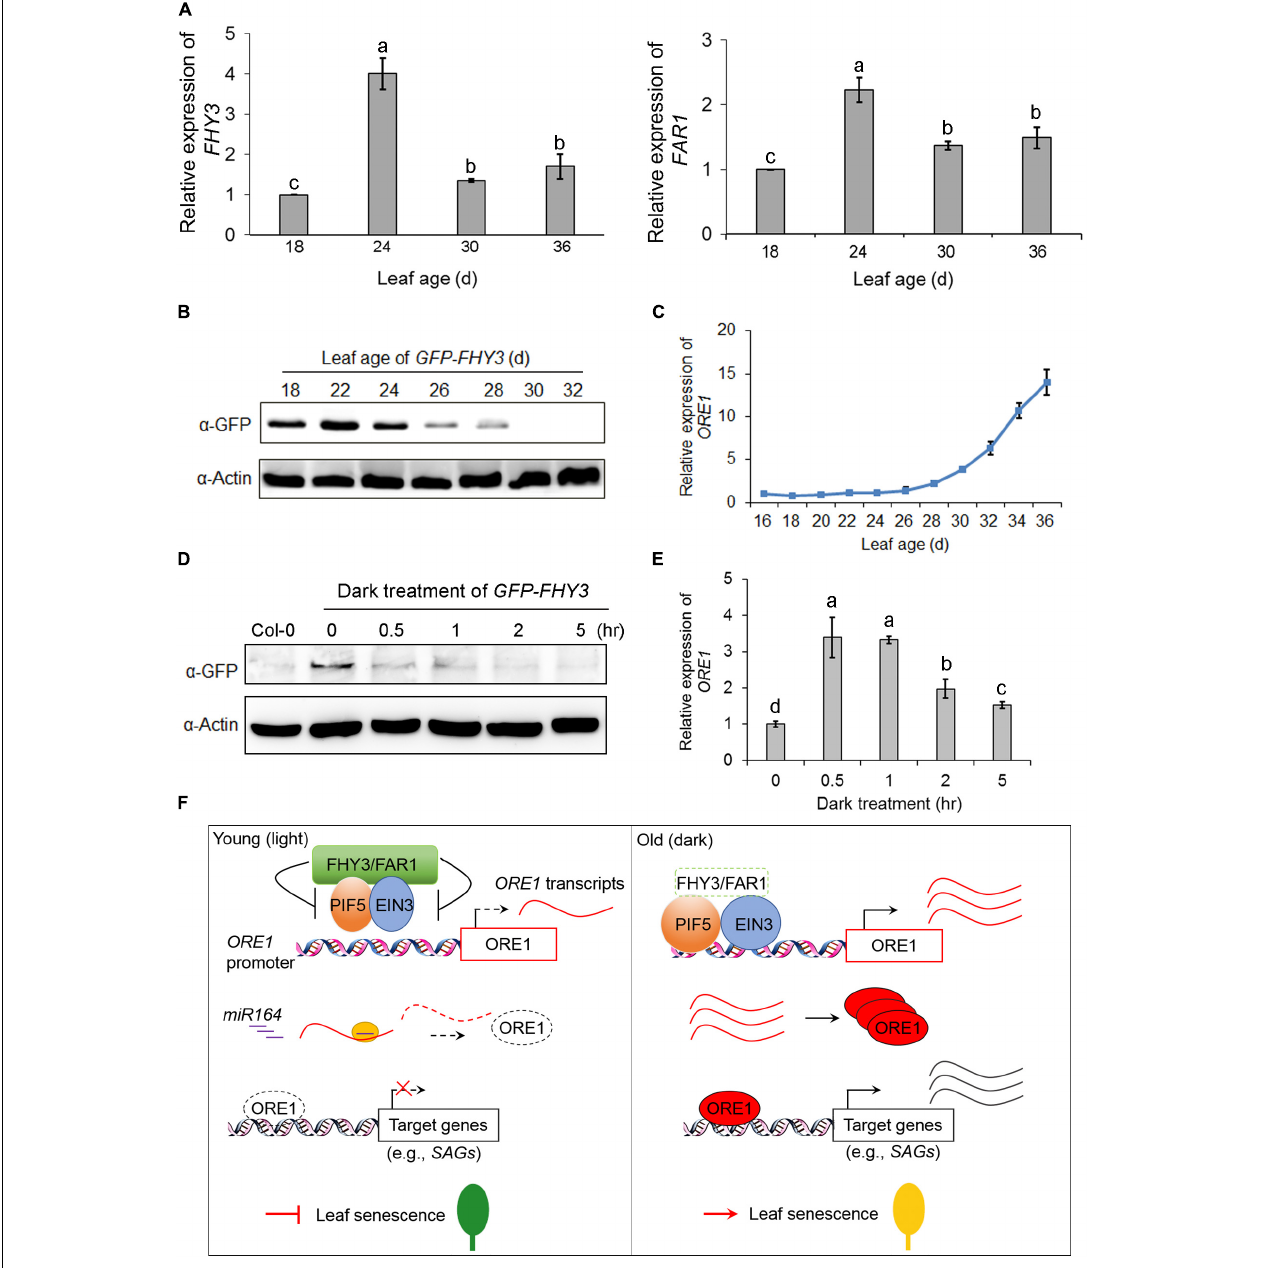
FIGURE 7 | qRT-PCR analysis of FHY3 and FAR1 transcripts and immunoblot analysis of FHY3 protein accumulation. (A) qRT-PCR analysis of FHY3 (left) and FAR1 (right) expression in the fourth leaves of Col-0 at the indicated leaf age. Error bars represent SD ( n = 3). Letters indicate significant differences by LSD test ( p < 0.05). (B) Immunoblot assays showing GFP-FHY3 fusion protein levels in the fourth leaves of the GFP-FHY3 overexpressors at the indicated leaf age. Actin was used as the internal control. (C) qRT-PCR analysis of ORE1 expression in the fourth leaves of the GFP-FHY3 overexpressors at the indicated leaf age. Error bars represent SD ( n = 3). (D) Western blotting assay showing that FHY3 protein level rapidly declined in seedlings treated with darkness. The GFP-FHY3 overexpressor seedlings were grown in continuous light for 7 days and then incubated in darkness for the indicated time lengths and then harvested for immunoblot analysis. Anti-GFP antibodies were used to detect FHY3 proteins and actin was adopted as a loading control. (E) qRT-PCR analysis of ORE1 expression in the fourth leaves of the GFP-FHY3 overexpressors at the indicated points of dark treatment. Error bars represent SD ( n = 3). Letters indicate significant differences by LSD test ( p < 0.05). (F) A proposed age gating model of FHY3 and FAR1 in regulating leaf senescence. In young, green leaves (or under light conditions), FHY3 protein is accumulated above a threshold level, and it represses the DNA binding activity of EIN3 and PIF5 to the ORE1 promoter, thus repressing ORE1 expression. In addition, ORE1 transcript is targeted for degradation by miR164 at a posttranscriptional level. As a result, leaf senescence is inhibited (left). In old leaves (or under darkness), FHY3 and FAR1 protein levels decrease, thus lifting their repression on EIN3 and PIF5, leading to ORE1 expression. Meanwhile, ORE1 transcript accumulates due to reduced expression of MIR164 , allowing translation of ORE1 protein to promote leaf senescence